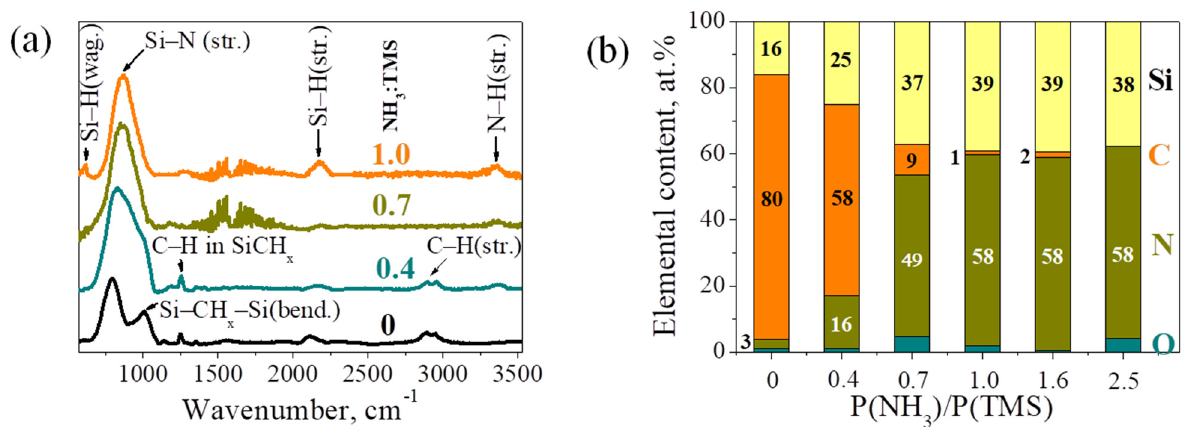
Figure 5. FTIR spectra ( a ) and EDX elemental composition ( b ) of SiC:H (SiCN:H) films deposited using TMS/NH 3 gas mixture at 400 ° C .